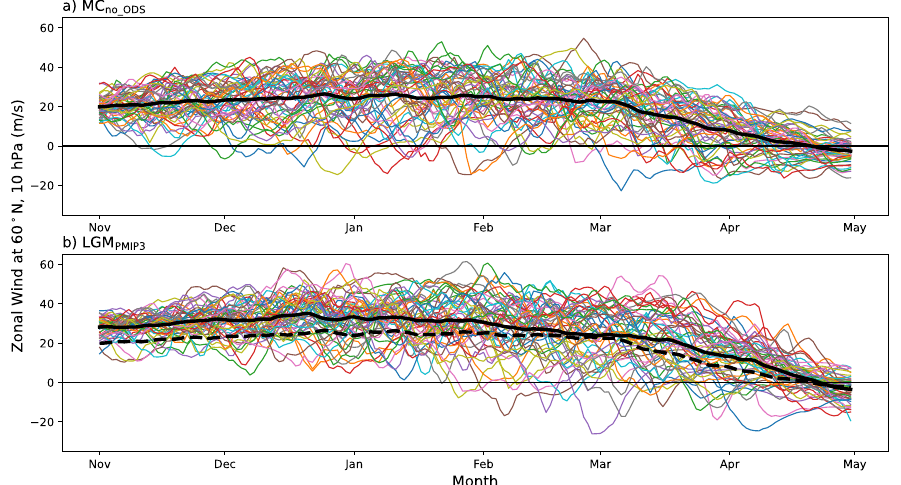
Figure 5. Daily time series of zonal-mean zonal wind at 60° N and 10 hPa from November to May with each year over-plotted (thin color lines) for 50 years for the simulations of ( a ) modern climate without ozone depleting substance (MC no_ODS ) and ( b ) Last Glacial Maximum with the PMIP3-simulated SST (LGM PMIP3 ). The thick black line is the 50 years average. The thick black dashed line in ( b ) is the 50 years average of MC no_ODS for a direct comparison.